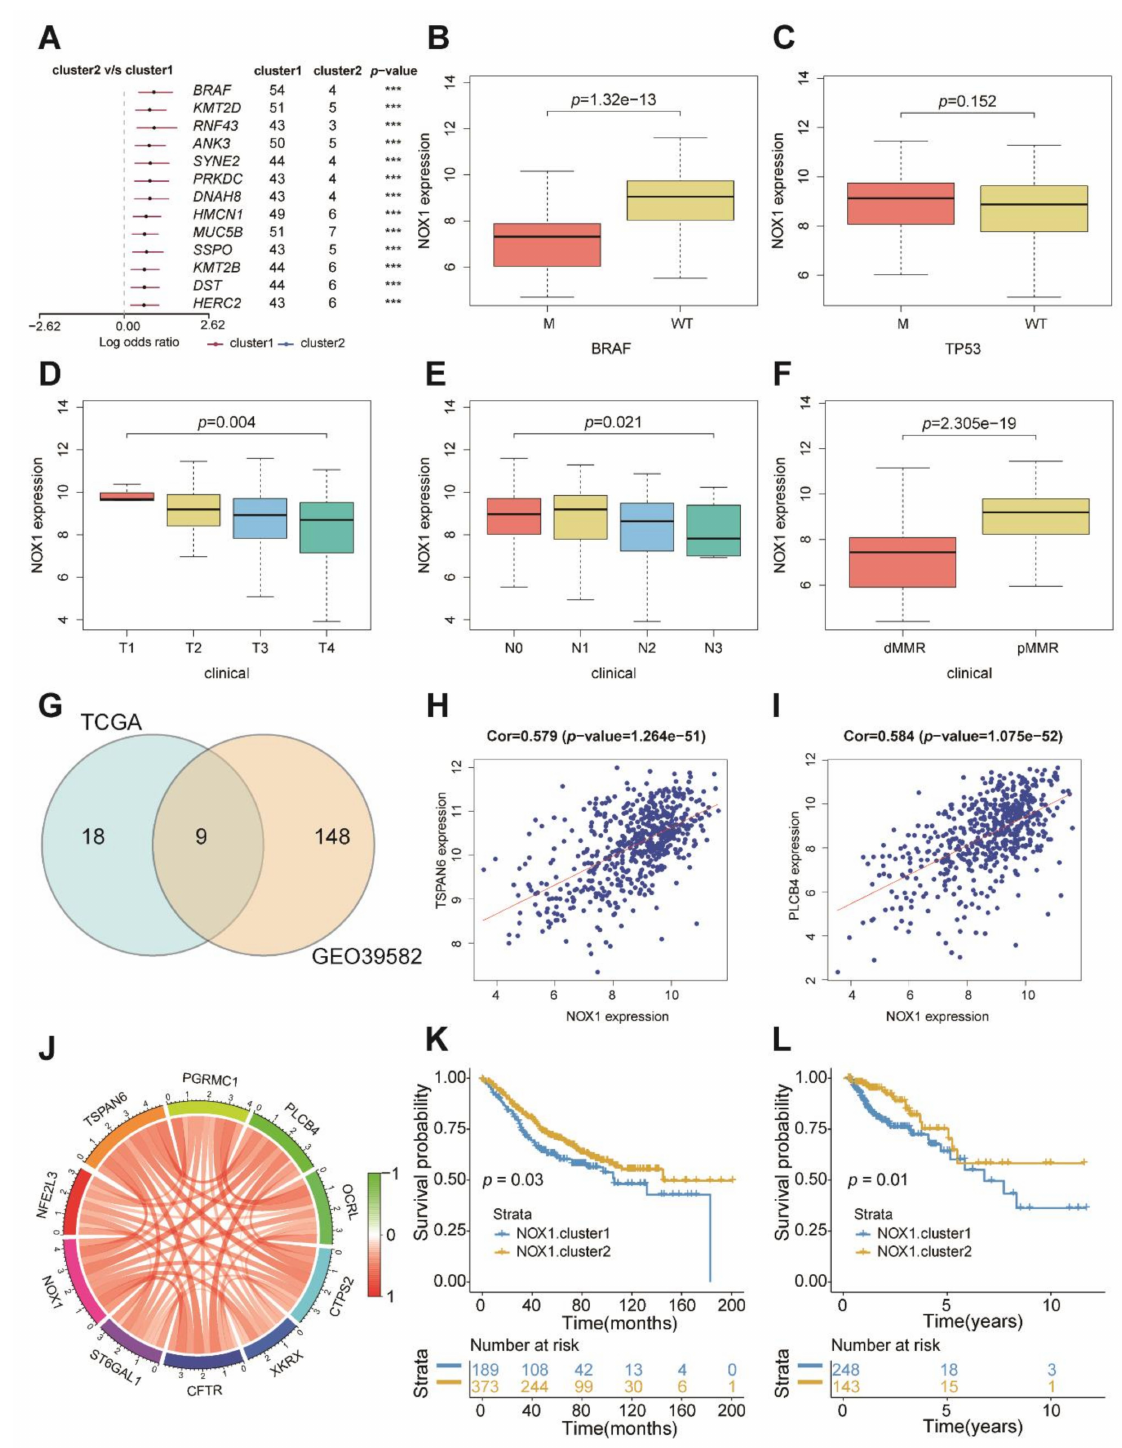
Figure 4. The role of NOX1 in survival. ( A ) Different mutation genes between cluster1 and cluster2 (**** p < 0.0001, ns means no significance). ( B – F ) The relationship between NOX1 expression and clinical features of patients. ( G ) 9 genes related to NOX1 from the TCGA and GEO39582 databases in Venn diagram. ( H ) The relationship between TSPAN6 and NOX1. ( I ) The relationship between PLCB4 and NOX1. ( J ) The relationship between 9 genes related to NOX1 and NOX1 ( K , L ) Survival analyses for patients based on NOX1-related gene expression in GSE39582 ( K ) and TCGA ( L